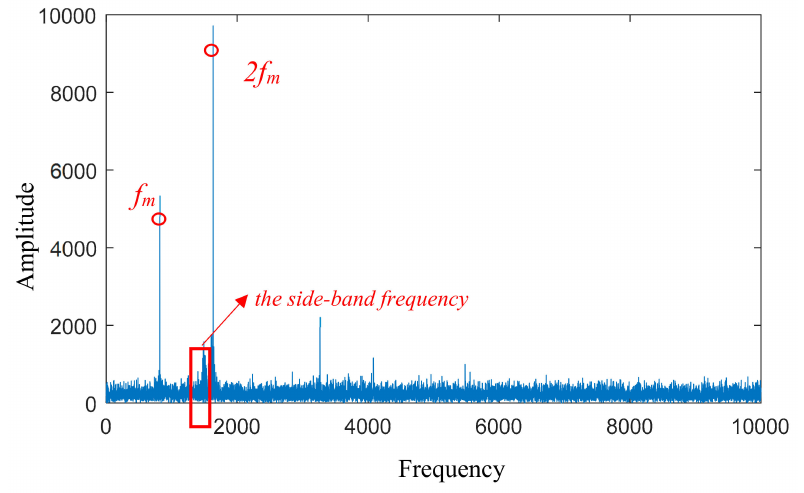
Figure 13. The segmentation of the frequency spectrum with 5dB of noise.